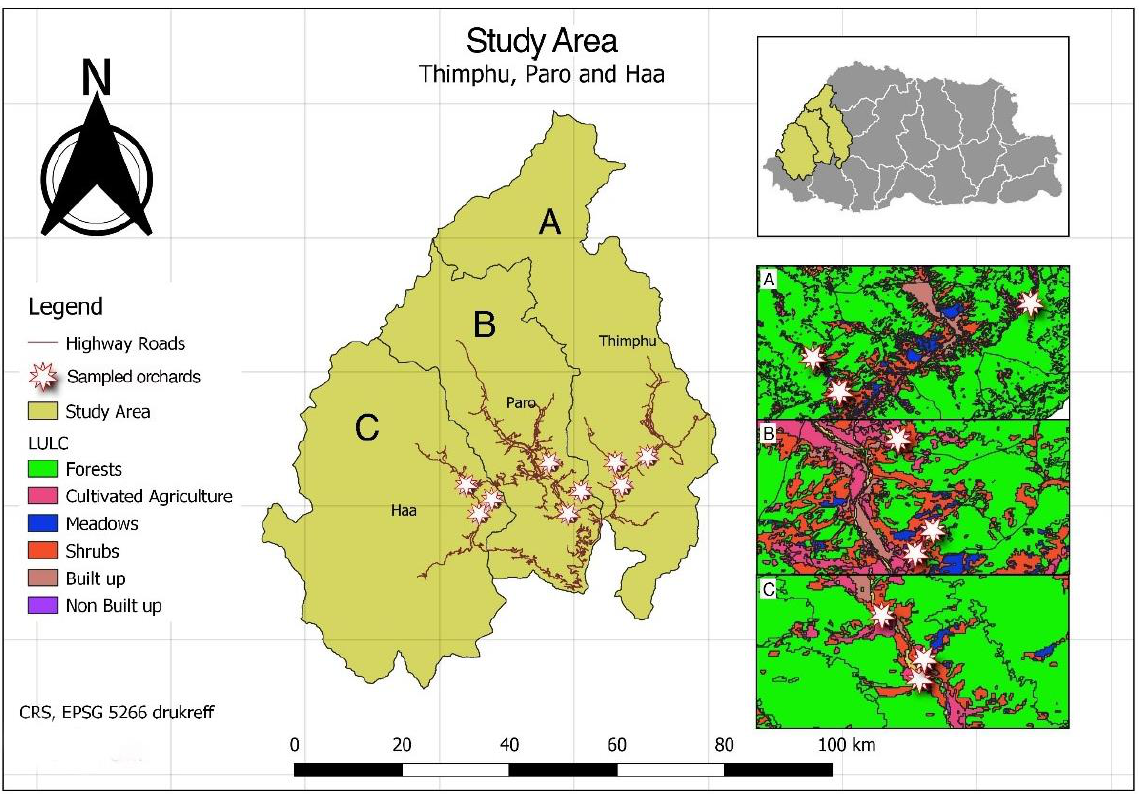
Figure 1. Location of the sampled orchards in each of the districts; (A) Thimphu, (B) Paro and (C) Haa, showing landscape context surrounding each